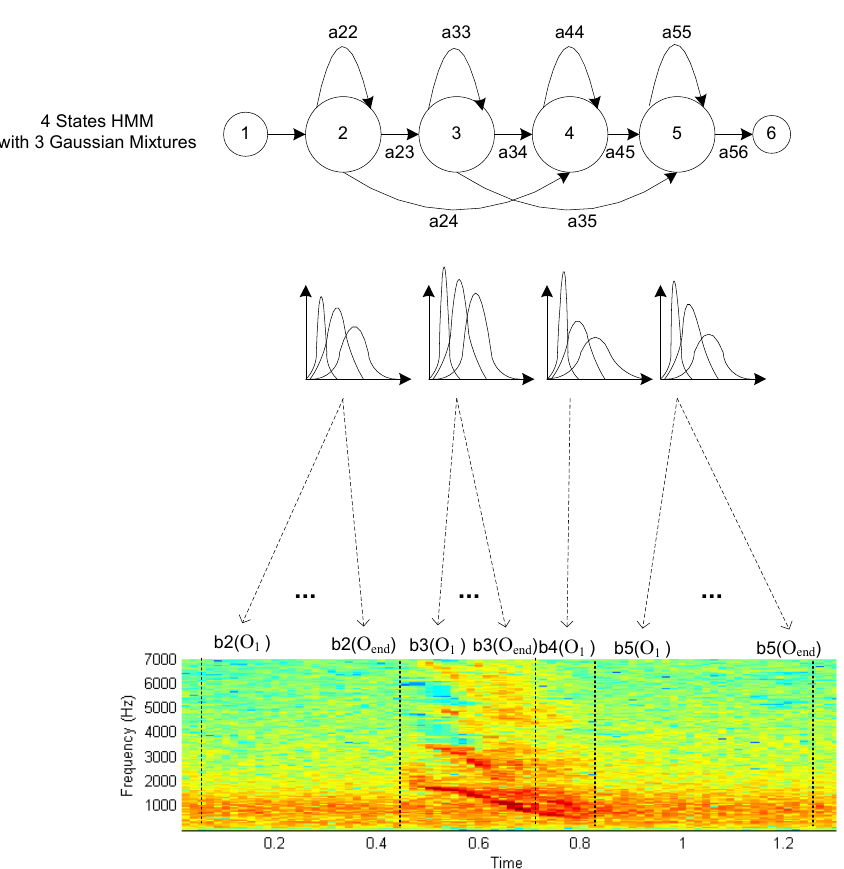
Figure 1. HMM with GMM state observations aligned to an Asian Elephant Squeak vocalization. The first and last state represent entry and exit points for the model, while internal states, called “emitting” states, are aligned to signal frames to maximize overall model